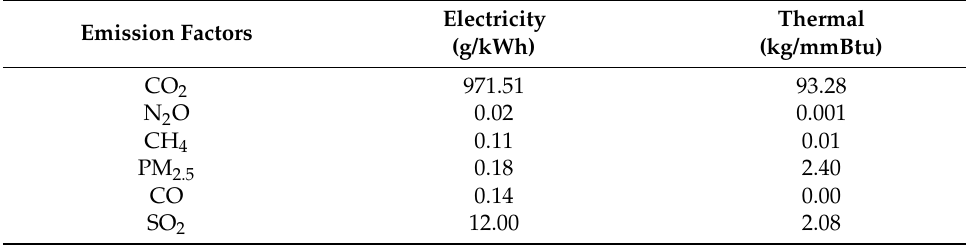
Electricity Thermal (g/kWh)